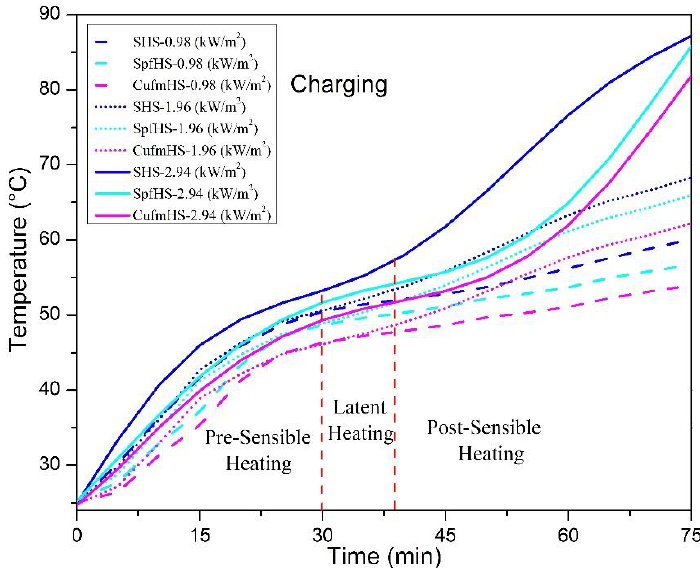
Figure 8. Base temperature distribution of heat sinks at various heat fluxes.